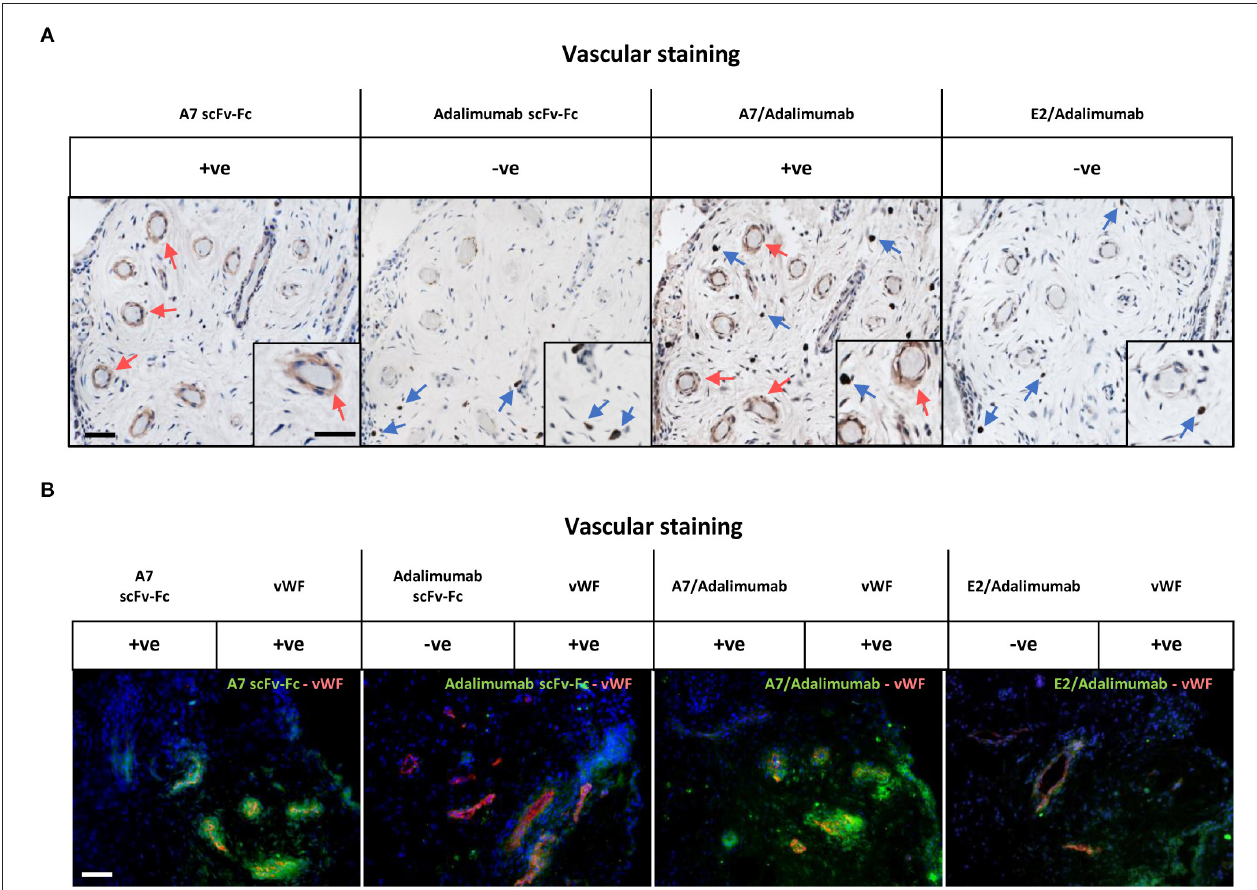
FIGURE 2 | Reactivity in the human arthritic synovium. (A) Immunohistochemistry on human arthritic synovium stained with biotinylated A7 scFv-Fc, adalimumab scFv-Fc, A7/adalimumab and E2/adalimumab at 20 µ g/ml ( n = 3). Binding of antibody to tissue section detected with horseradish peroxidase (HRP) conjugated avidin–biotin complex. Red arrows indicate A7 staining. Blue arrows indicate anti-TNF staining. Insert represents magnification of vasculature and reactive cells. (B) Immunofluorescent staining on arthritic synovium with biotinylated A7 scFv-Fc, adalimumab scFv-Fc, bispecific A7/adalimumab, and bispecific E2/adalimumab at 20 µ g/ml in combination with anti-von Willebrand factor (vWF). Biotinylated antibody detected with streptavidin-Alexa Fluor 488 (green). Anti-vWF detected with anti-mouse Alexa Fluor 555 (red). DAPI counterstain to depict nuclei (blue). Scale bar in representative pictures 100 µ